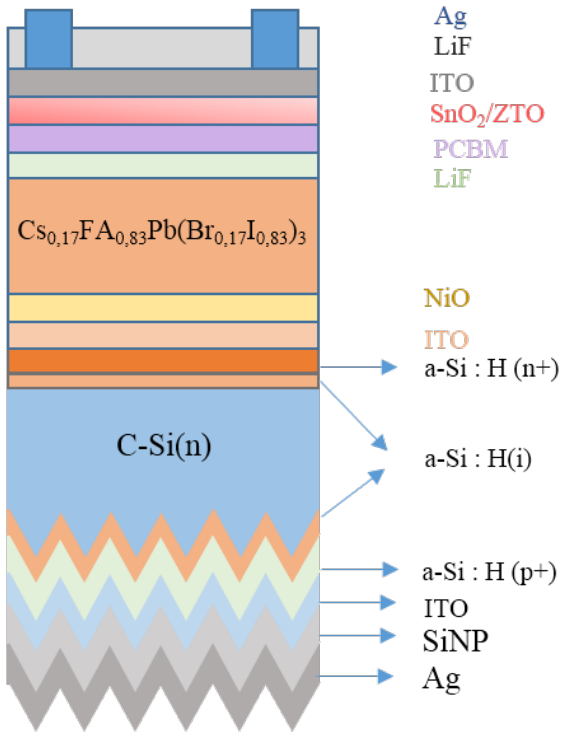
Figure 15: The record monolithic perovskite / silicon tandem cell